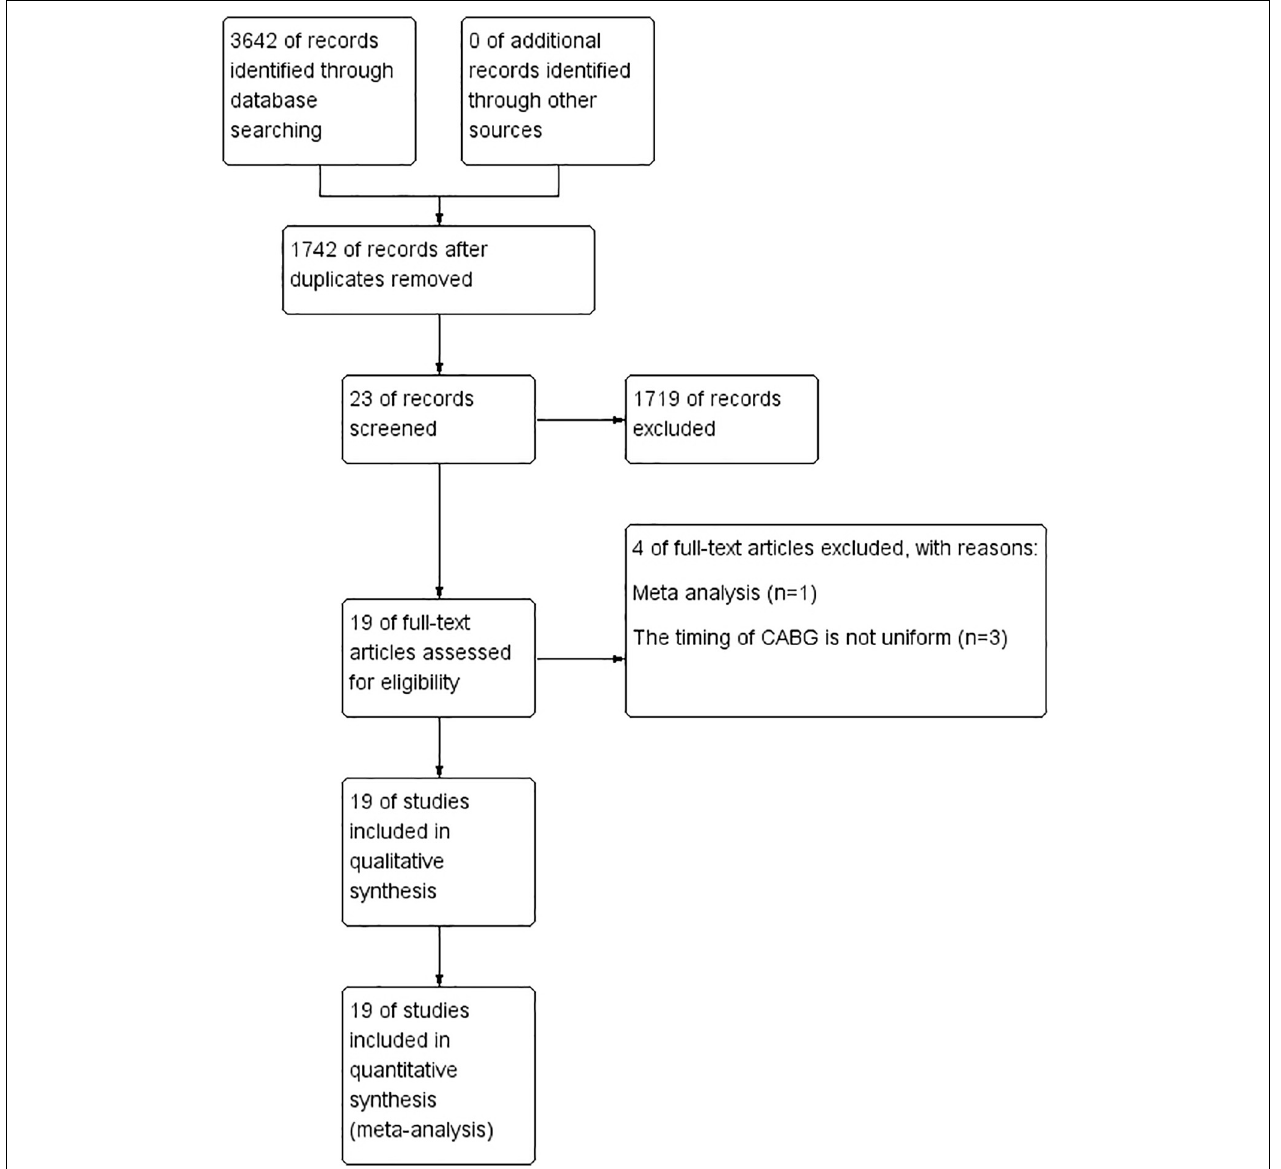
FIGURE 1 | Study selection flow